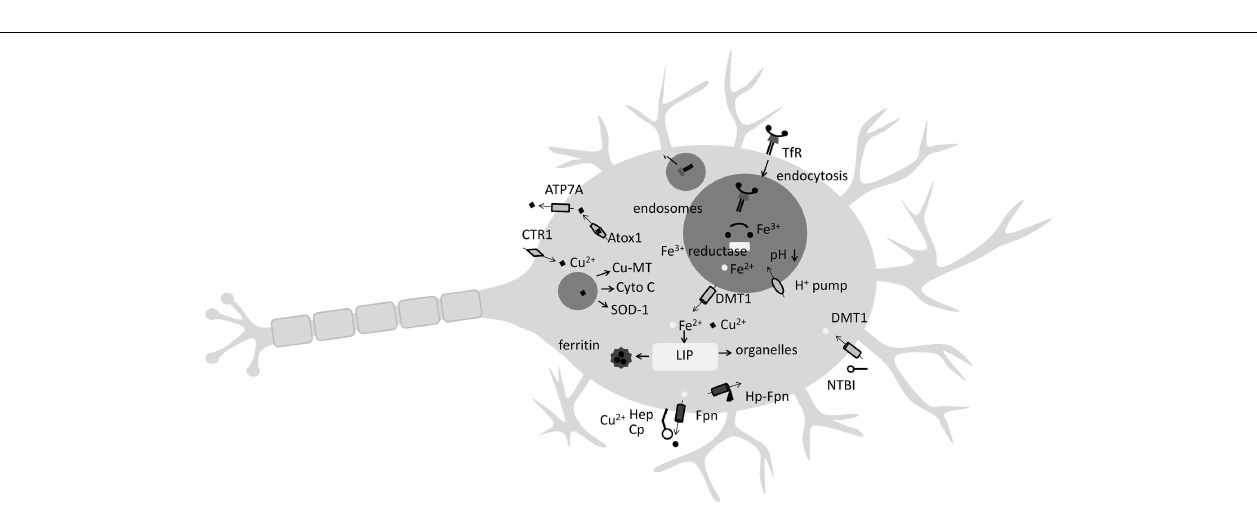
FIGURE 1 | Key features of Fe and Cu uptake and release by the neuron . Iron (Fe) is either acquired by non-transferrin bound Fe (NTBI) from low-molecular weight complexes with citrate or ascorbate or by endocytosis of the transferrin (Tf)-transferrin receptor complex (TfR). Once endocytosed, a decrease in pH and the action of a ferrioxidase enables Fe 2 + release to the labile Fe pool (LIP) by divalent metal transporter 1 (DMT1) where it may be stored in the Fe-storage protein ferritin, or